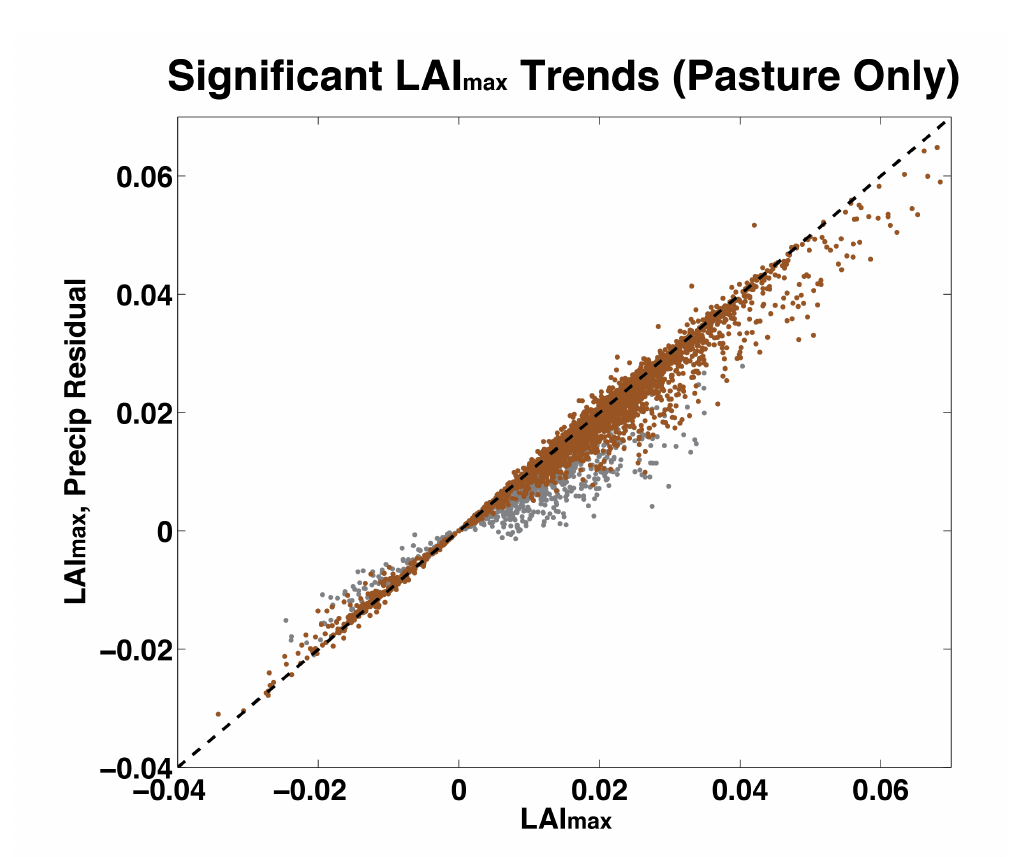
Figure 5. Comparisons of significant LAImax trends calculated for pasture cells ( i.e ., cells with ≥ 10% pasture cover) for trends calculated before (x–axis) and after (y–axis) detrending the influence of annual precipitation. The 1:1 line is black and dashed, representing identical trends between the two methods. Cells for which trends became insignificant after precipitation detrending are in